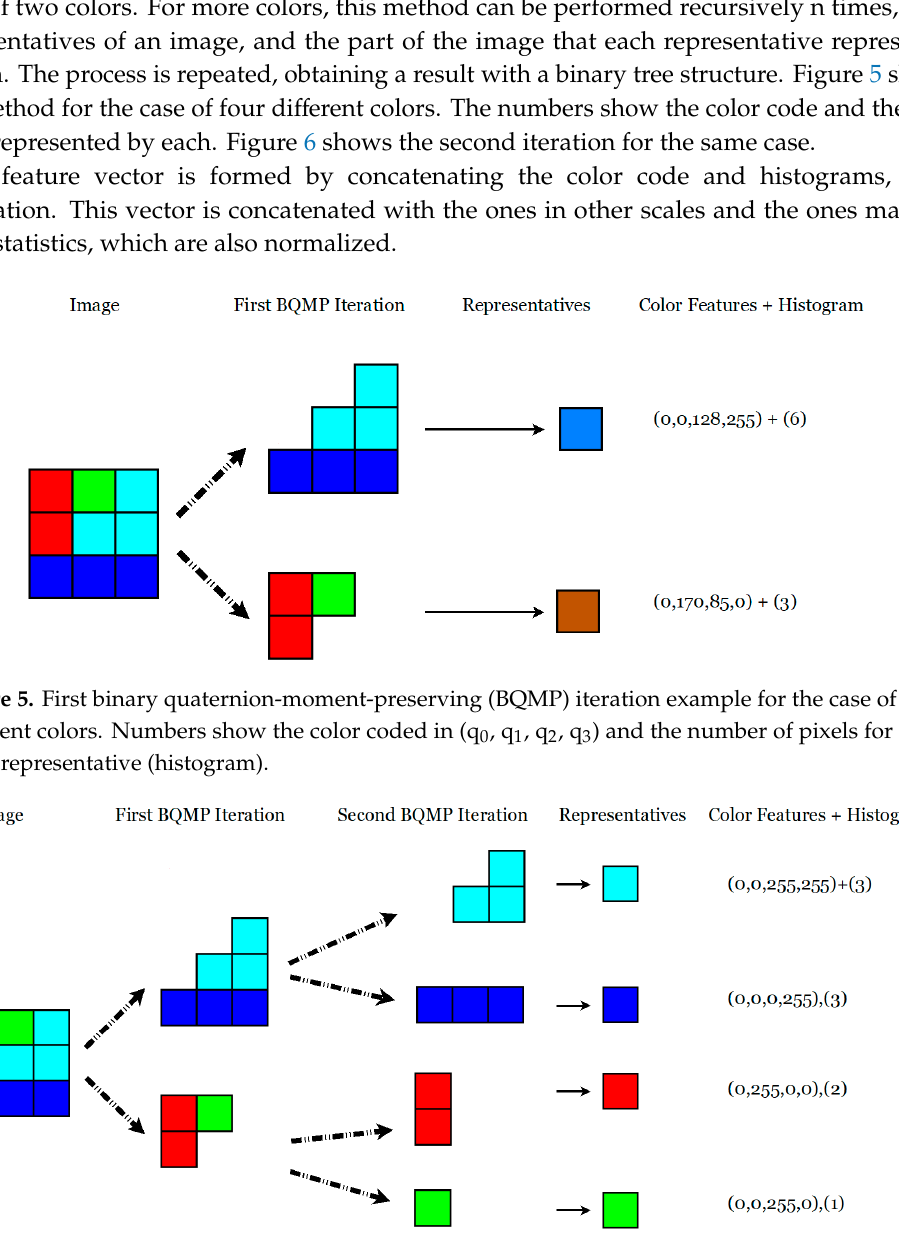
Figure 6. Second BQMP iteration example for the case of four different colors. Numbers show the color coded in (q 0 , q 1 , q 2 , q 3 ) and the number of pixels for each color representative (histogram). The feature vector is formed by concatenating the color code and histograms, through